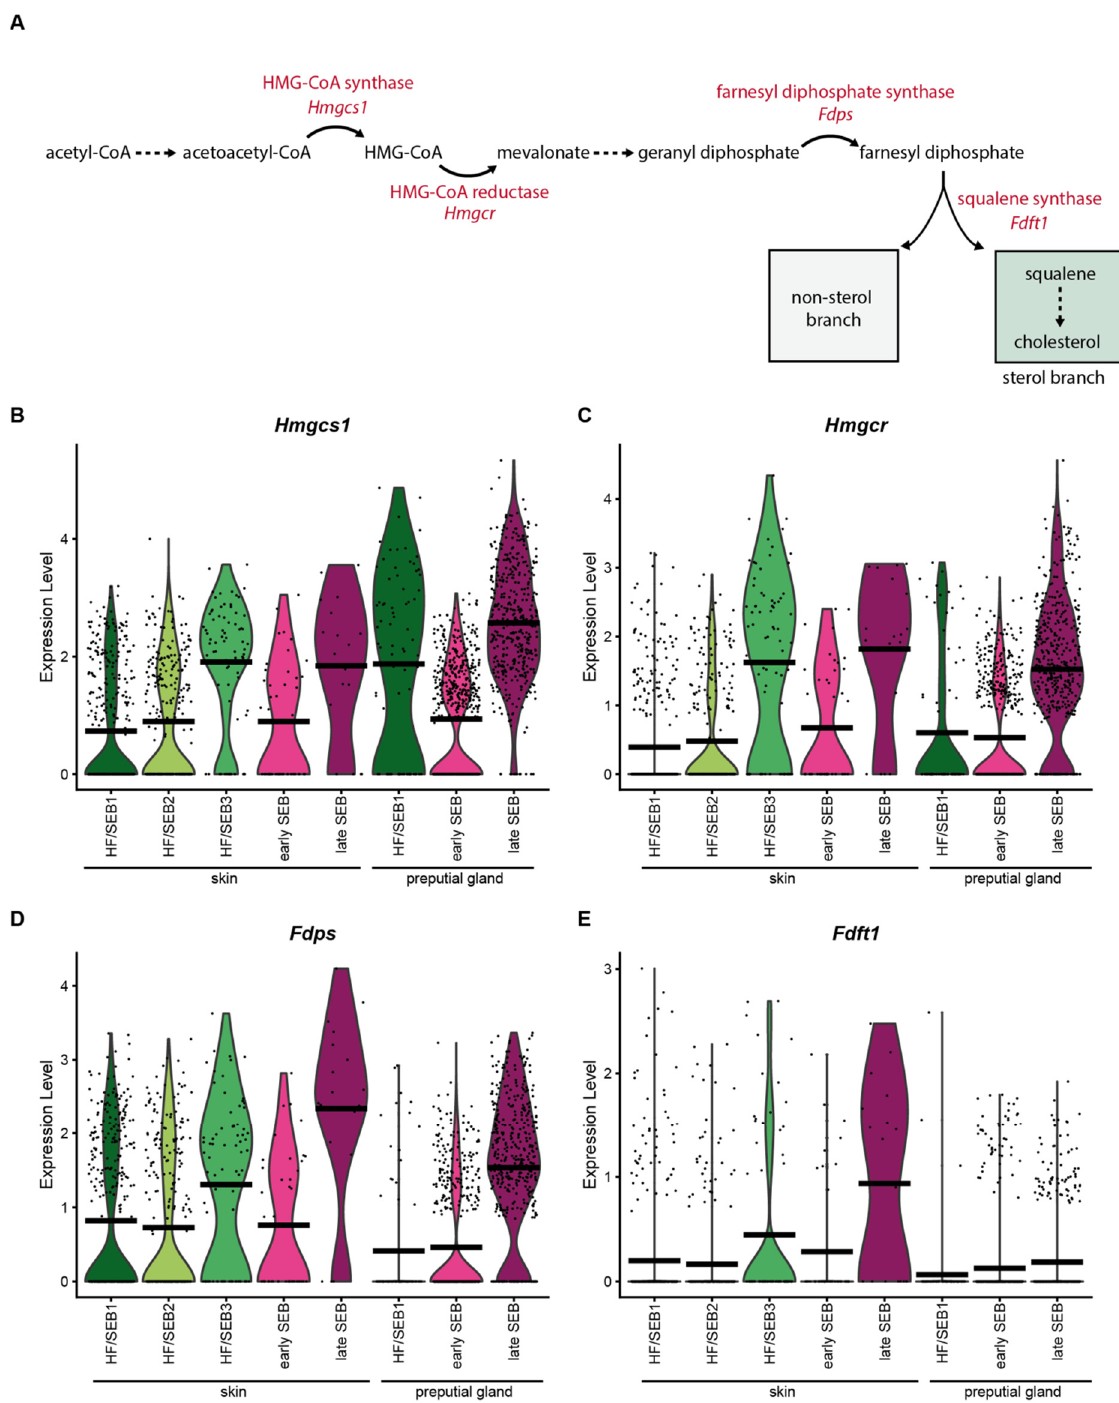
Figure 4. Key enzymes of the mevalonate lipid synthesis pathway are less expressed in preputial gland sebocytes. ( A ) Schematic depiction of the mevalonate pathway and key enzymes involved in the synthesis of squalene. ( B – E ) Violin plots showing the expression level of ( B ) HMG-CoA-synthase ( Hmgcs1 ), ( C ) HMG-CoA reductase ( Hmgcr ), ( D ) farnesyl diphosphate synthase ( Fdps ), and ( E ) squalene synthase ( Fdft1 ). Violin plots show gene expression levels and crossbar of violin plots depicts mean expression value. Vertical lines show maximum expression. Width of violins represents the frequency of cells at the corresponding expression levels.